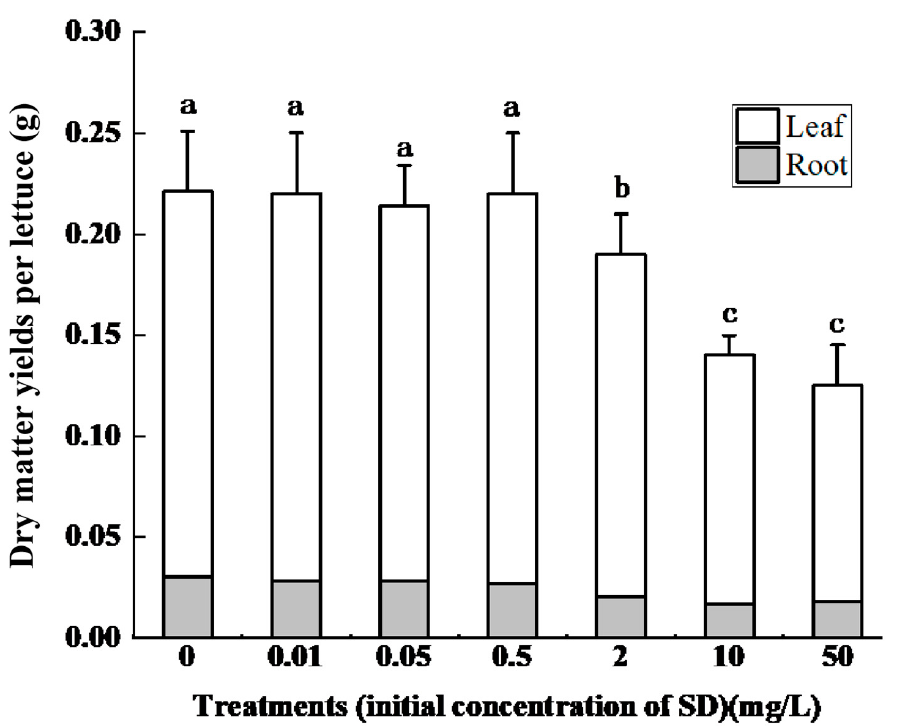
Figure 1. Effect of SD concentration on the dry matter yields per lettuce ( n = 10). Error bars represent standard deviations of the means. a, b, and c on the top of the error bars represent significant differences ( p < 0.05) among different initial concentrations of treatments.